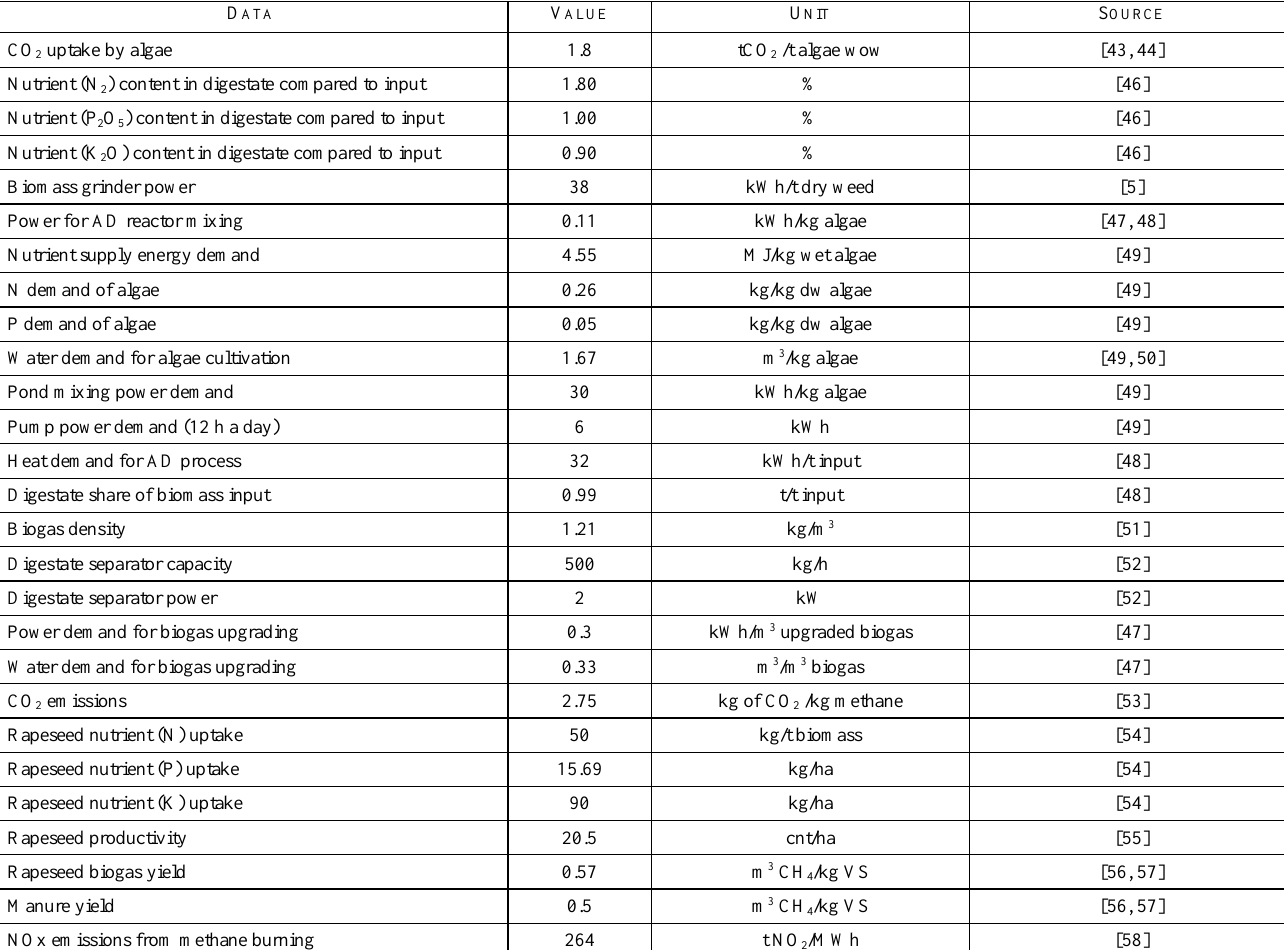
P RINCIPAL I NVENTORY D ATA FOR LCA M ODELING